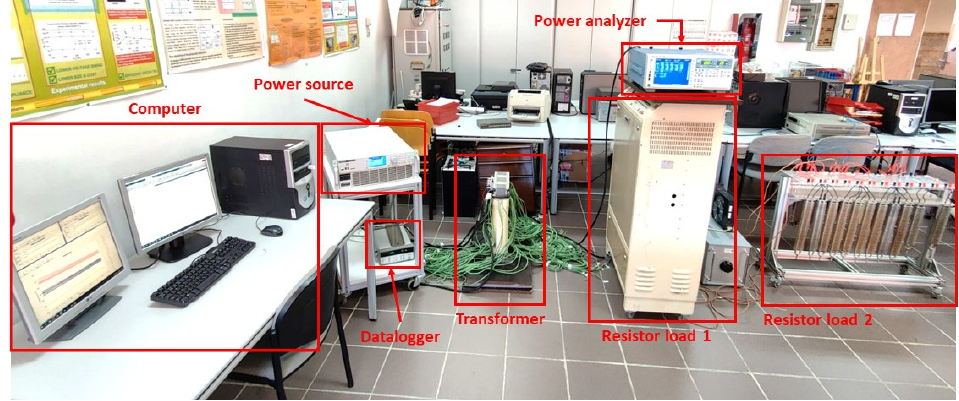
Figure 5. Global view of the total setup connection.